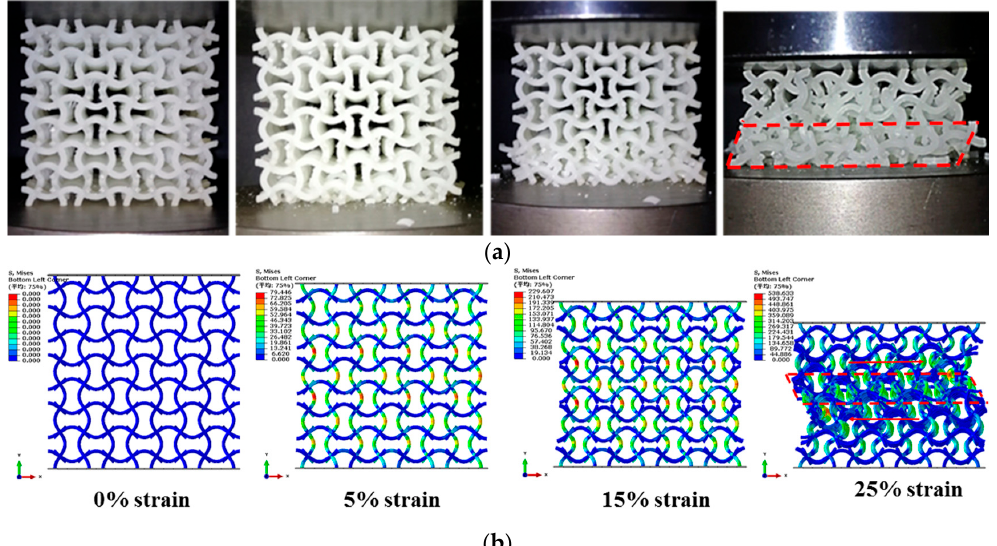
Figure 9. Front view of collapse modes of the NPR CCF3 under quasi-static uniaxial compressions in the y direction: ( a ) experiment; ( b ) numerical simulation (until 25% strain).